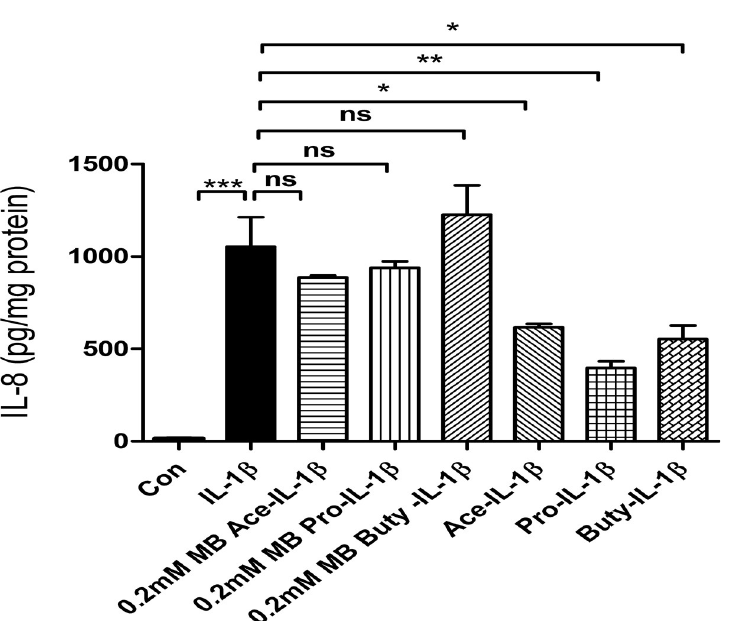
Fig 8. 109A is required for SCFAs anti IL-1 β induced IL8 induction in H4 cells. H4 cells were pretreated with 109A inhibitor mepenzolate bromide (MB) (0.2mM) for 30 minutes then treated with SCFAs before IL-1 β stimulation. The secretion of IL-8 into the supernatants was assayed by Elisa. Data are represented as the mean ± SEM of three independent experiments. n = 3. One -way ANOVA and Tukey post hoc tests were used for statistic ( � p < 0.05, �� p < 0.01, ��� p <